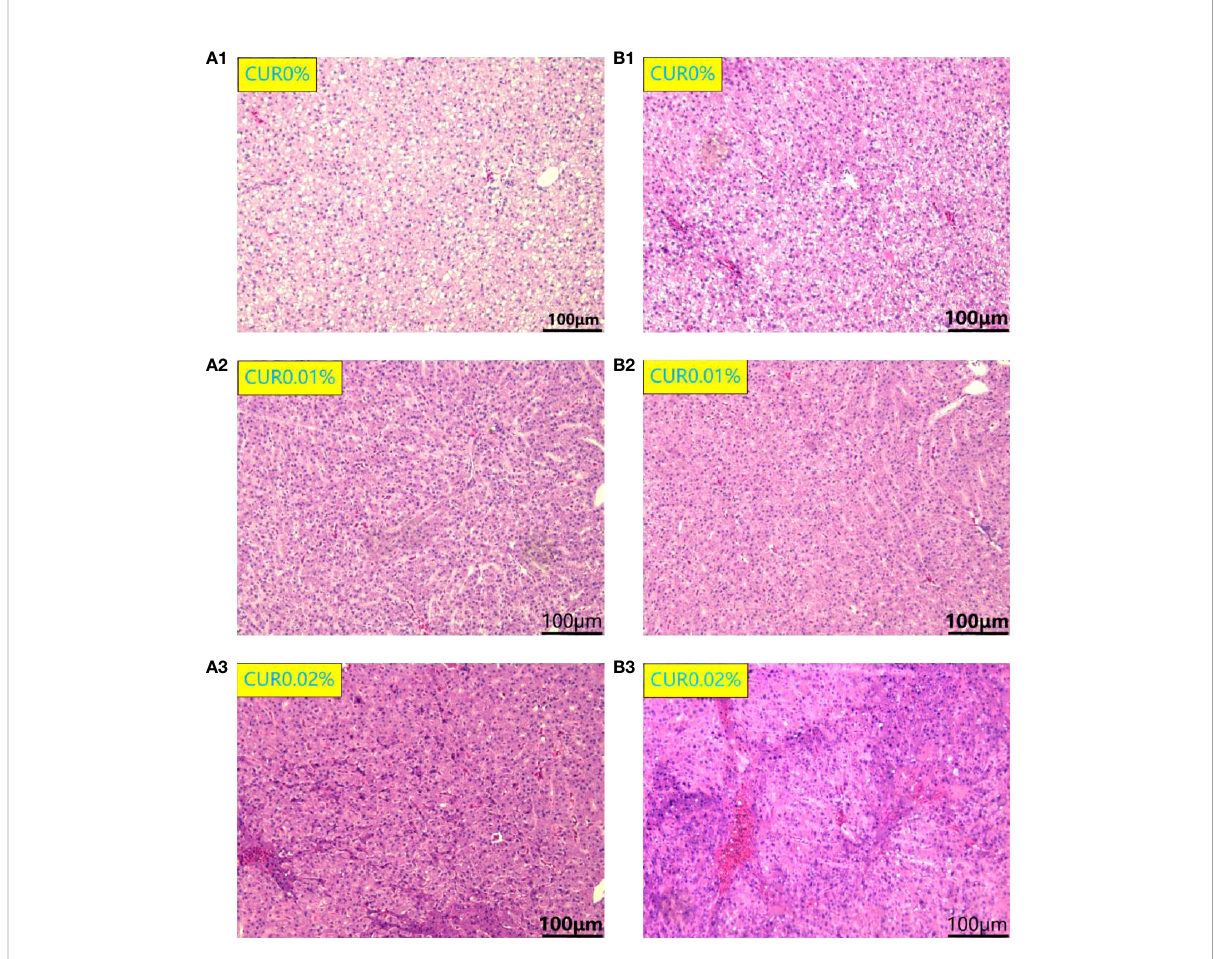
FIGURE 6 Liver histological structure of different groups of the greater amberjack after ammonia challenge (A1-3) and after recovery (B1-3)